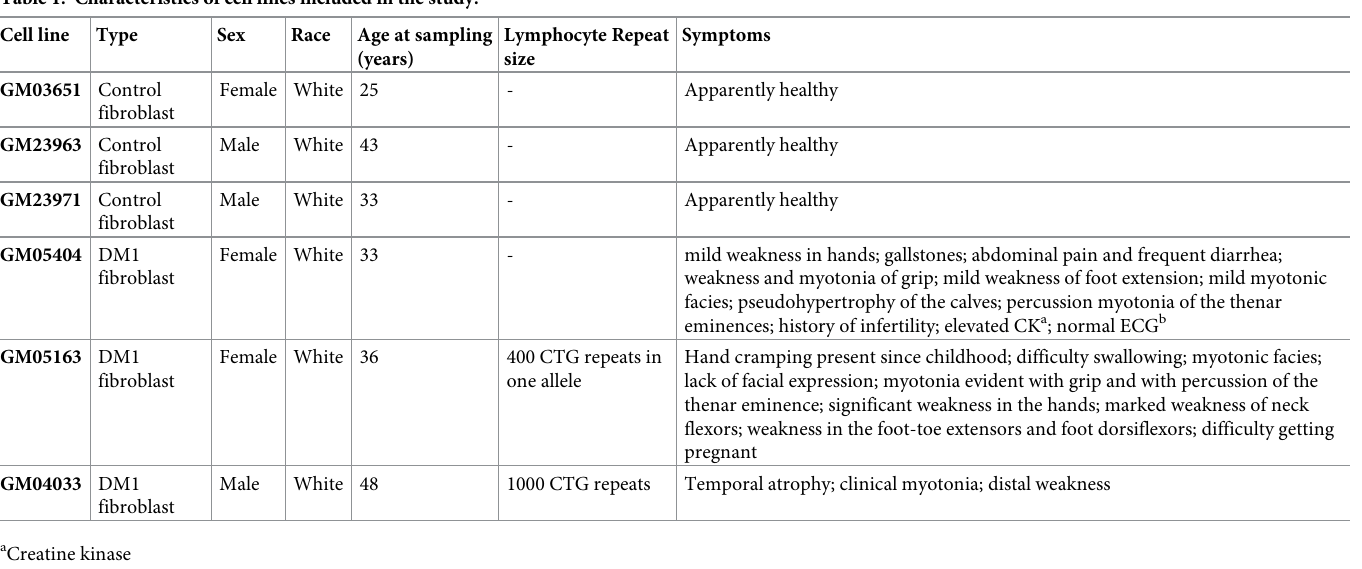
Table 1. Characteristics of cell lines included in the